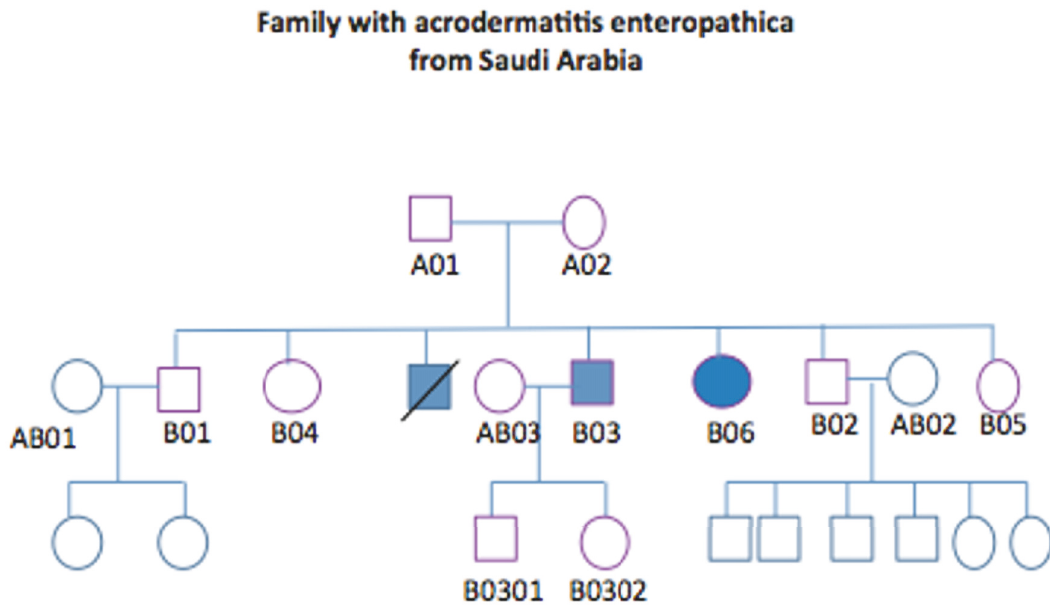
Figure 1: Pedigree analysis to demonstrate the family of AE and the sequenced individuals for this study. Genome sequence of the following samples: A01, A02, B03, AB01, and AB02. Only B03 and B06 are affected (one male sibling was also affected, but he died). Note. Shading in blue displays the individuals affected by the